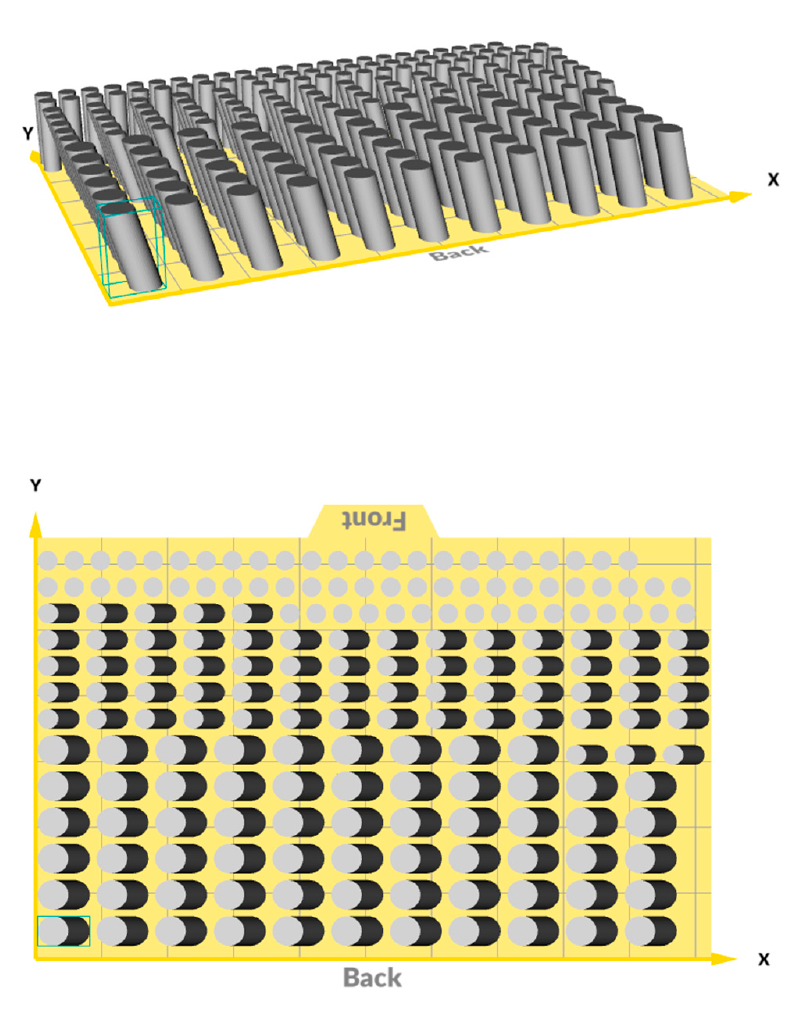
Figure 6. Components (64 in number) of each CGx arranged on the building platform (side view and top view).